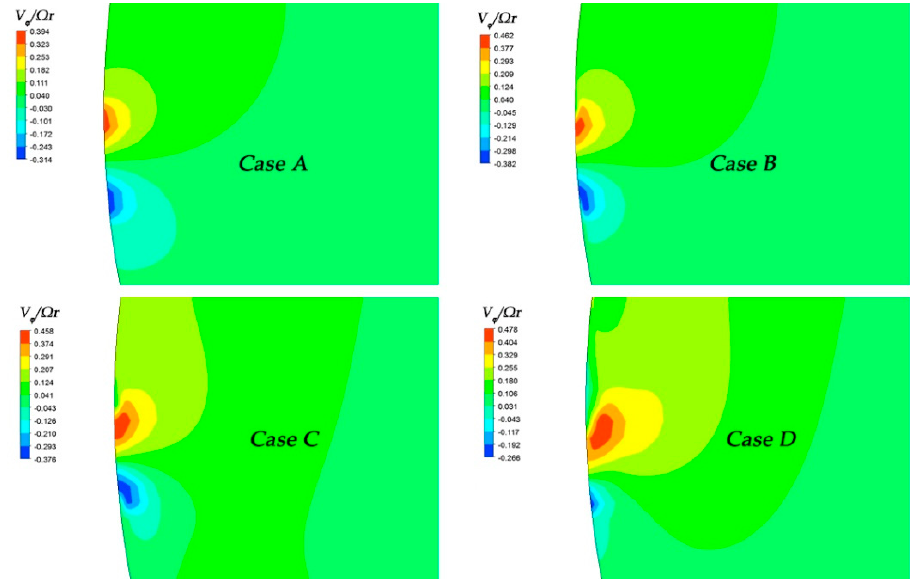
Figure 7. Contour of the β when E = 0.2, θ = 0.1 at z / s = 0.5. The distribution of the β in the circumferential direction for different Euler numbers and different θ numbers is shown in Figures 8 and 9, respectively. The dashed vertical lines in the figures represent the position of the downstream border of the low-pressure zone at different (cid:2016) numbers. It can be seen from the two figures that the effect of the E and the θ on the β after turbine blade fracture is similar. As the E or the θ increases, the fluctuation of the β increases, especially at high-radius locations. The standard deviation of the β at r / b = 0.44, 0.68, and 0.92 is 0.00381, 0.00576, and 0.01612, respectively, when E =